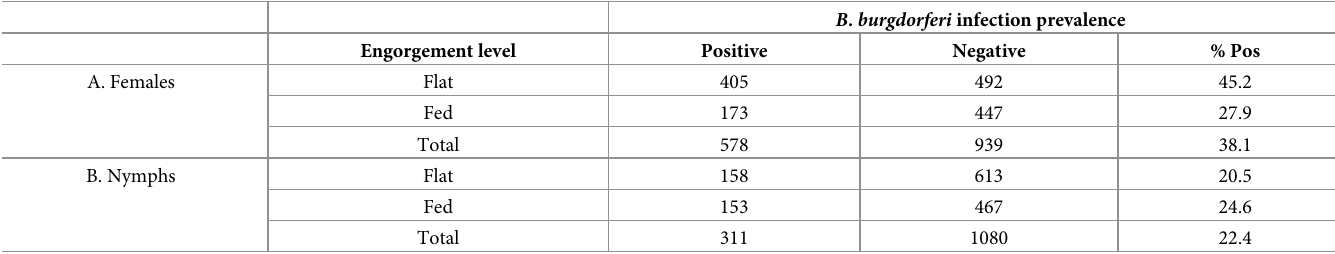
Table 6. Borrelia burgdorferi infection rates in flat vs. fed I . scapularis submitted